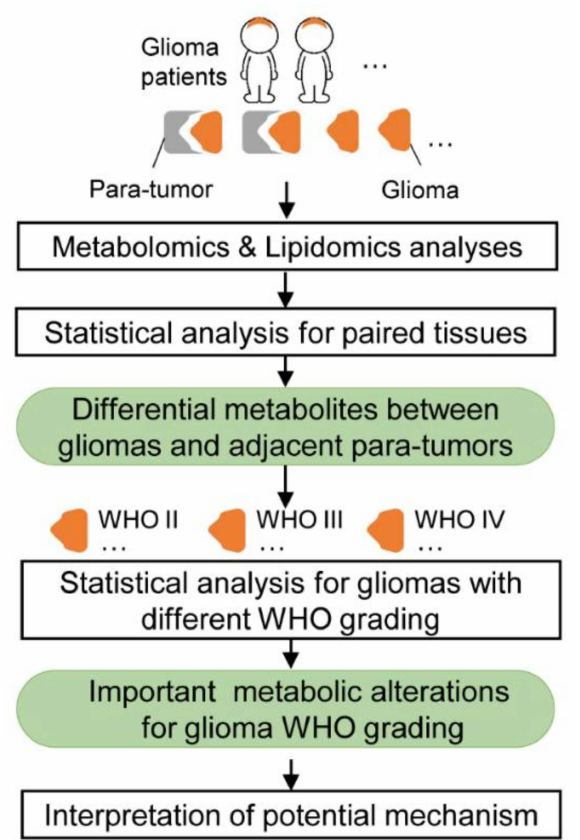
Figure 1. Scheme of the metabolic characterization study for di ff erent graded gliomas classified by world health organization